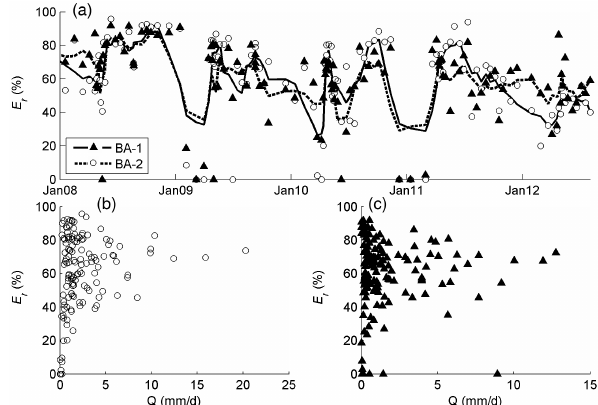
Figure 5. (a) Seasonal variation in NO − for the two downstream sites BA-1 and BA-2; lines represent mov- ing averages with n = 5. (b) E r vs. Q for the BA-2 catchment outlet and (c) E r vs. Q for the BA-1